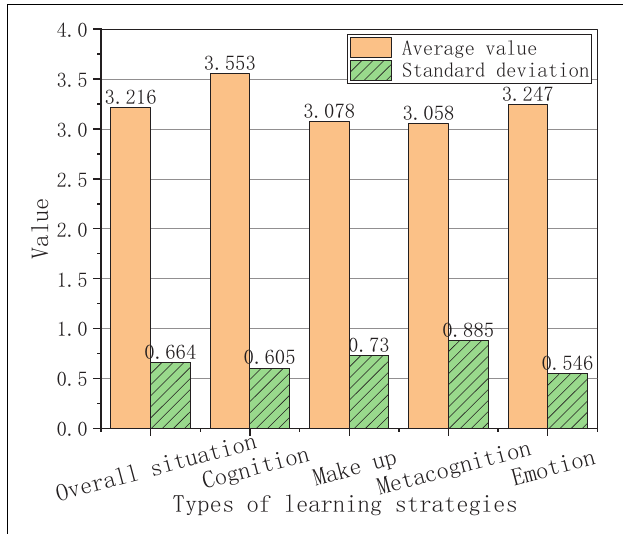
FIGURE 3 | Analysis of the use of each learning